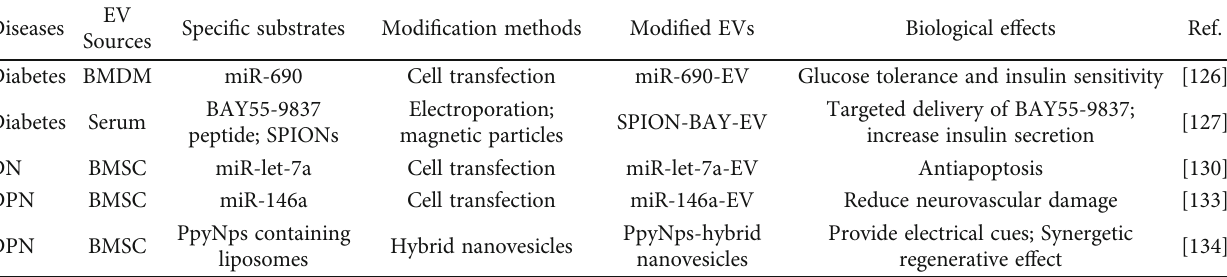
Table 6: Modi fi ed EVs in the therapy of diabetes and its